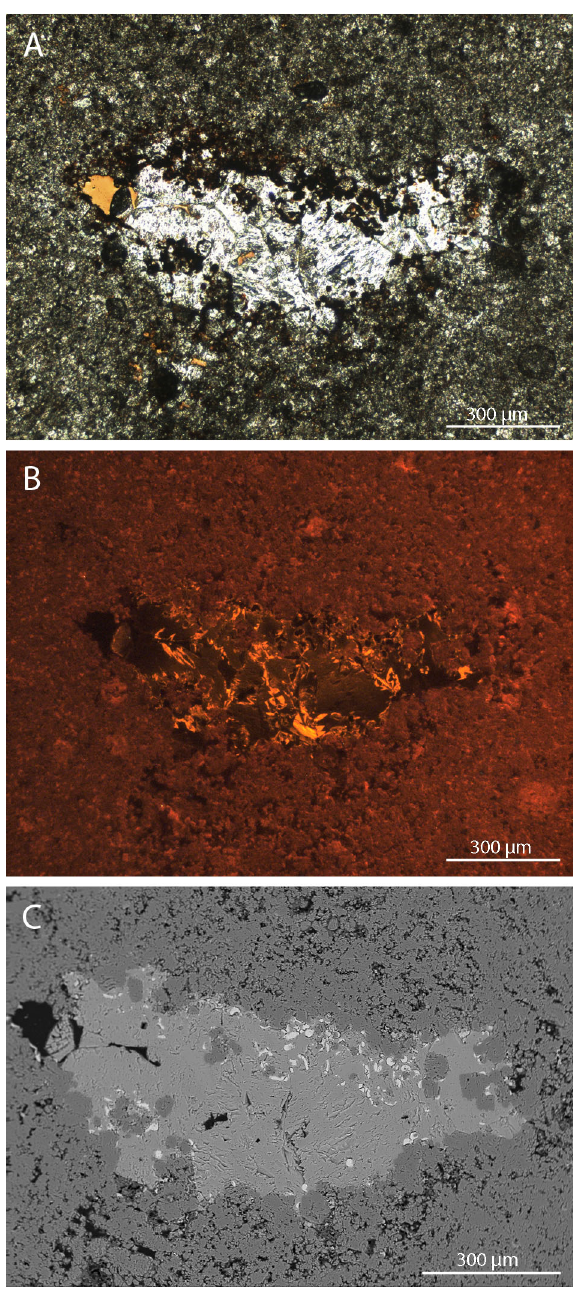
Fig. 7. Calcite-filled vug in very finely crystalline dolostone in light microscope ( A ), cathodoluminescence (CL) ( B ) and scanning electron microscopy (SEM) ( C ). In CL some calcite crystals show Mn content (clear orange CL colour in the colour image; white crystals in the black-and-white image). Energy dispersive spectrometry revealed tiny siderite crystals in the rimming parts of the calcite filling (white particles in grey matrix in SEM). Ape drill core, 3.8 m, GIT